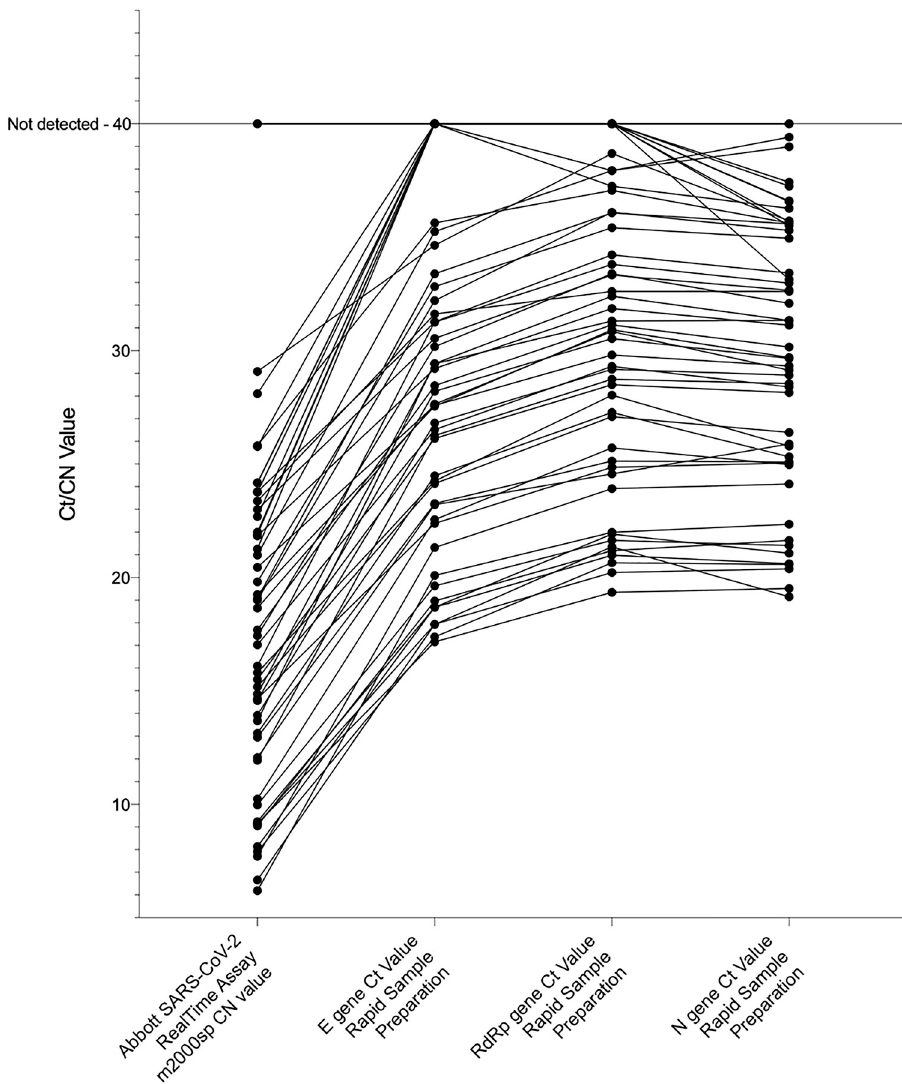
Fig 2. Comparison of target Ct and CN values after RSP and testing with the Abbott RealTime SARS-CoV-2 assay. The Ct values for the SARS-CoV-2 Envelope (E), RNA-dependent RNA-polymerase (RdRp) and Nucleocapsid (N) gene targets are shown for samples tested with the Allplex ™ 2019-nCoV assay after RSP and CN values after testing with the Abbott RealTime SARS-CoV-2 assay. A plotted CN or Ct value of 40 indicates that detectable amplification did not occur. The Abbott assay CN values are assay specific and not directly comparable to Ct values, but are shown to demonstrate the performance of the spectrum of selected samples.